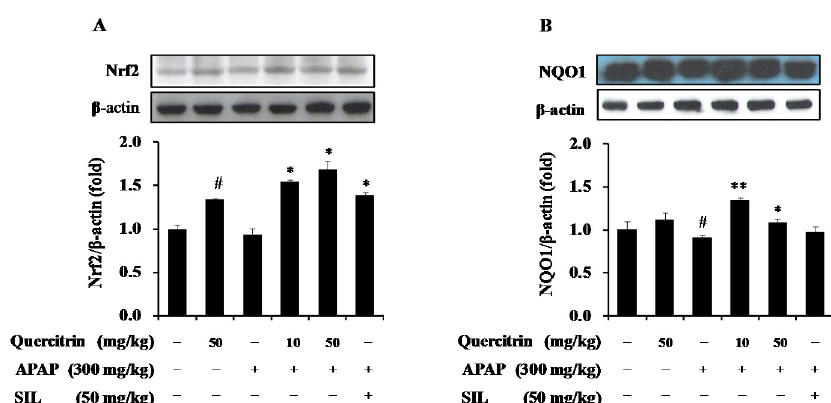
Figure 6. Effects of quercitrin on expressions of Nrf2 and NQO1 in APAP intoxicated mice. The protein levels of Nrf2 ( A ) and NQO1 ( B ) were measured by Western blot analysis as described in Materials and Methods section. Protein expression levels were normalized with β -actin. All data represent means ± SD of five mice in each group. Significant differences were ( # ) p < 0.05 as compared with the control; (**) p < 0.01 or (*) p < 0.05 as compared with APAP group.